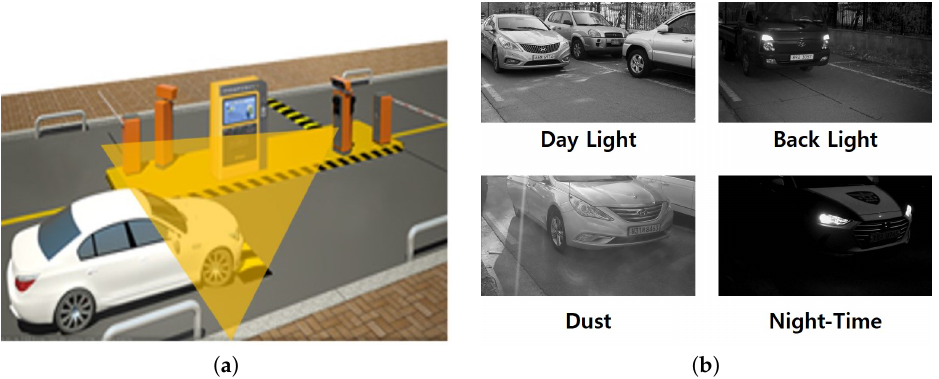
Figure 4. ( a ) Camera installation and ( b ) four different illumination